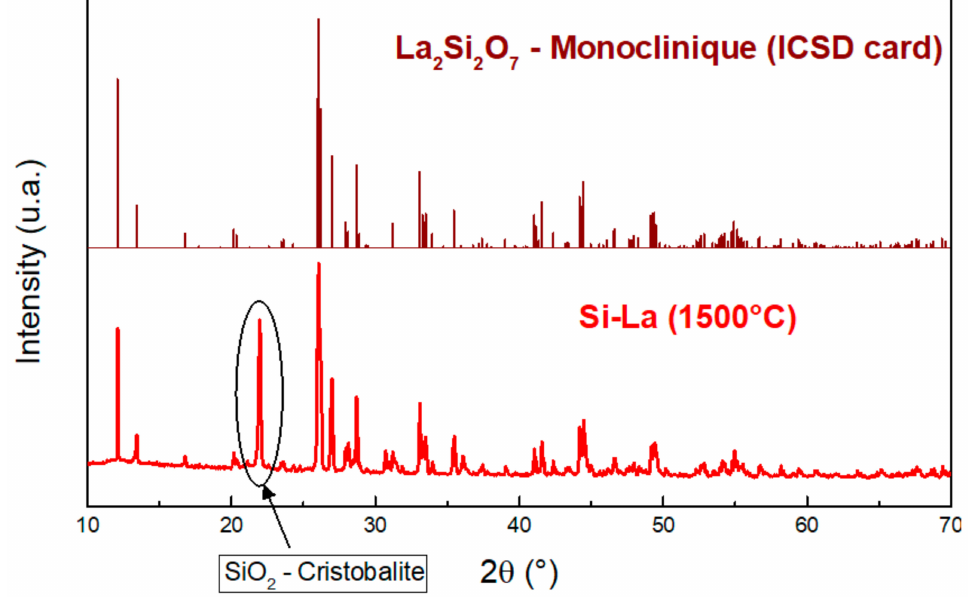
Figure 9. XRD patterns of Si-La after thermal treatment with the ICSD card of monoclinic La 2 Si 2 O 7 [30,31]. Adapted with permission from Ref. [30]. Copyright 2022, Zeitschrift fur Kristallo- graphie. Adapted with permission from Ref. [31]. Copyright 2022, Royal Society of